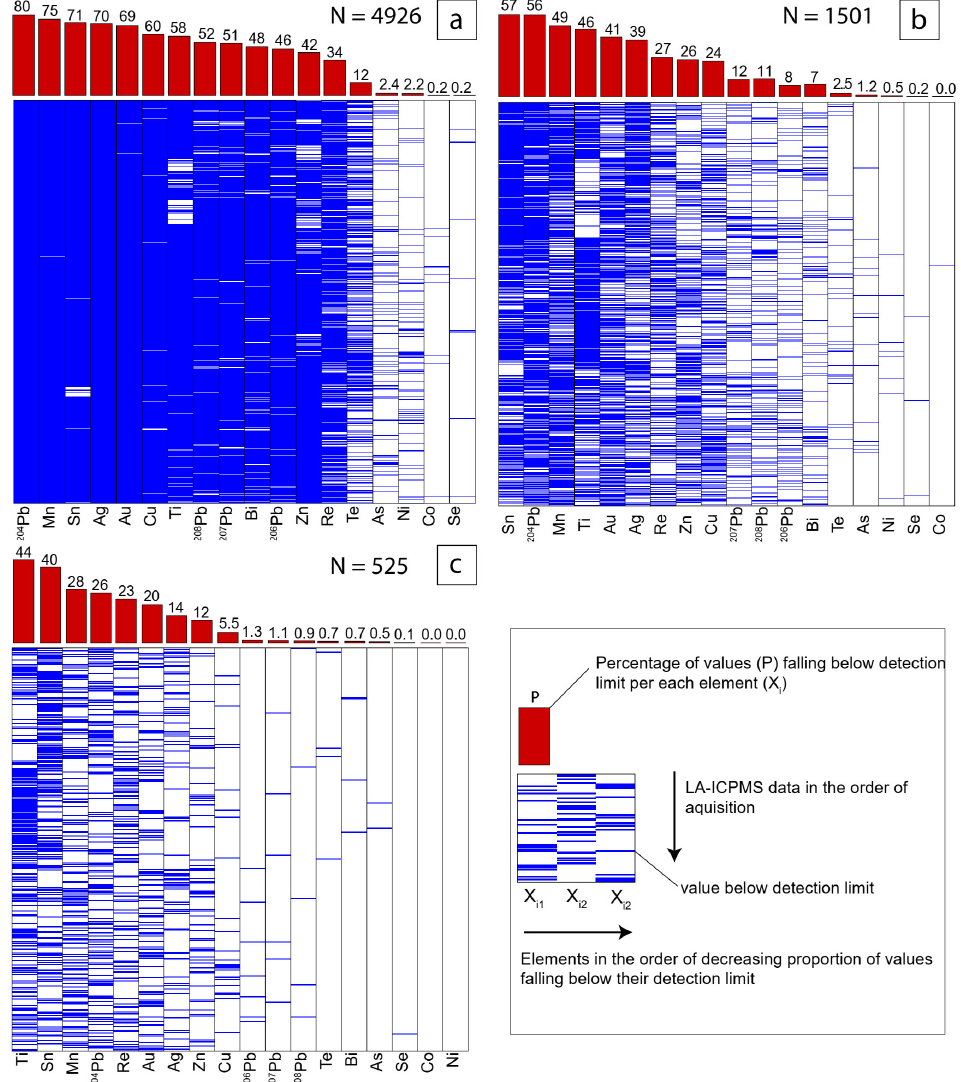
Figure 1. Schematic visualisation of measured and below mdl values for the ( a ) N = 4926, ( b ) N = 1501 and ( c ) N = 525 LA-ICP-MS pyrite datasets presented, from top to bottom, in the sequence of acquisition. The percentage of values being below detection limit is given for each element.